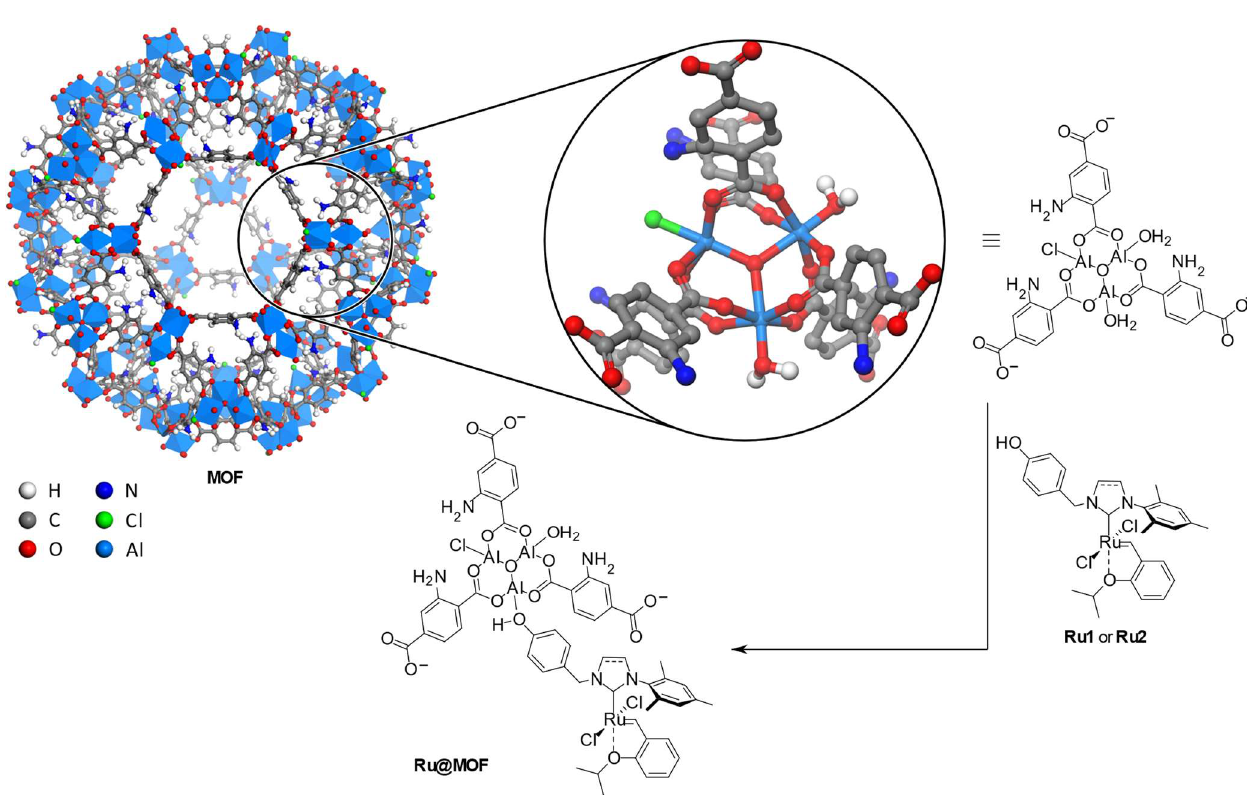
Scheme 1. Structure of (Al)MIL-101-NH 2 (hydrogen atoms were omitted for clarity) and the pro- posed mode of immobilisation of a phenol-tagged ruthenium